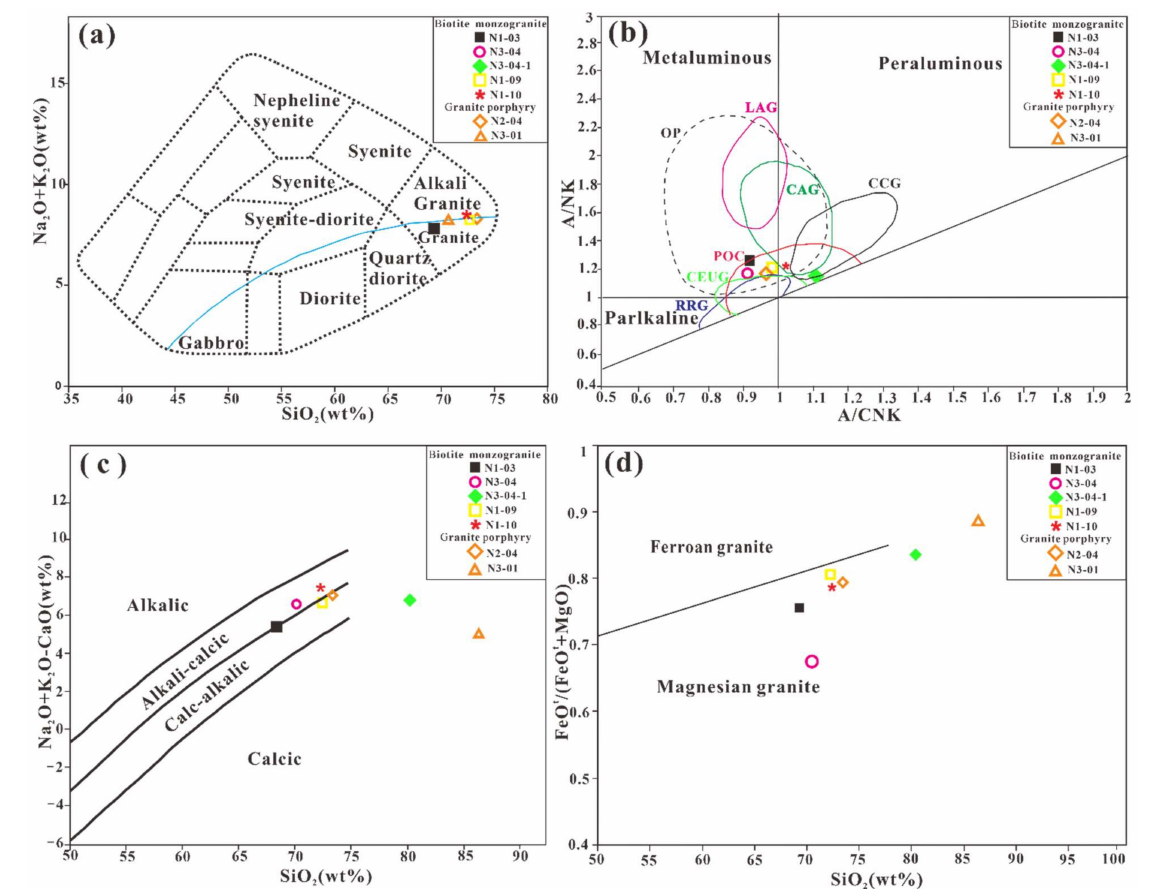
Figure 8. Major element diagrams for the Nianzigou granite. ( a ) Total alkalis versus silica diagram (after Middlemost [41]). ( b ) A/NK vs. A/CNK diagram (after Pearce [42]). ( c ) Na 2 O + K 2 O-CaO vs. SiO 2 diagram (after Peccerior [43]). ( d ) FeO t /(FeO t + MgO) vs. silica diagram (after Frost and Frost